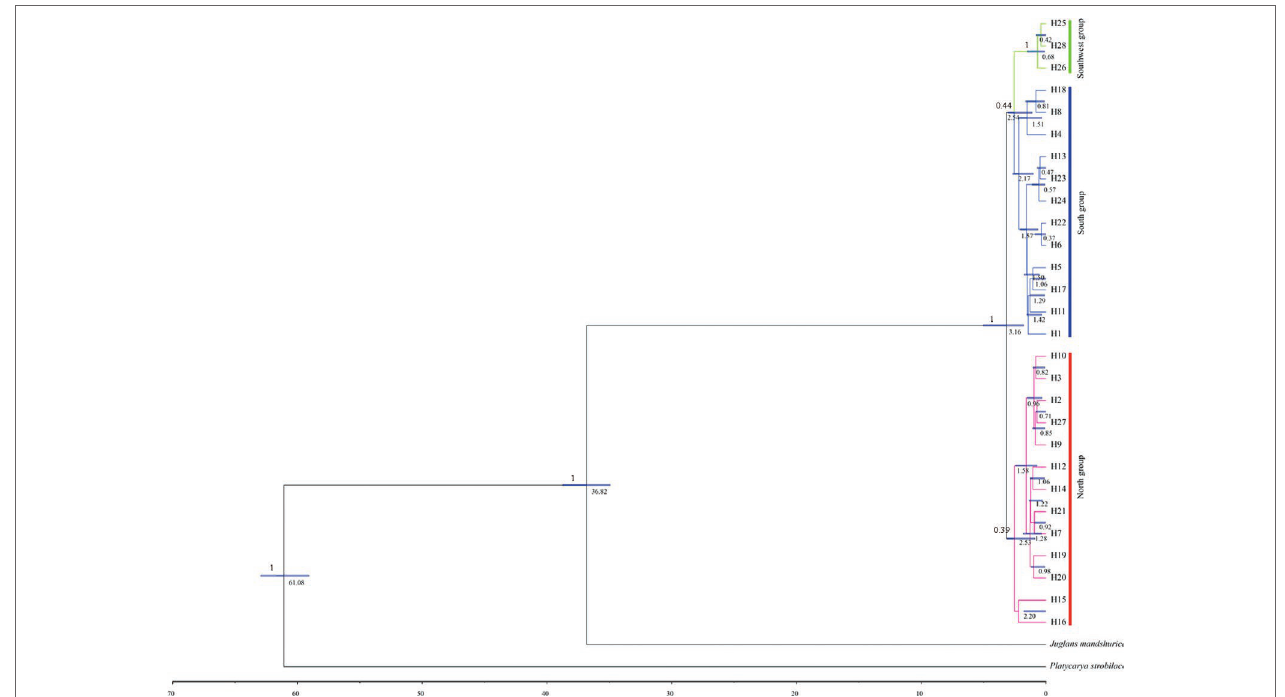
FIGURe 3 | Divergence time of Pterocarya stenoptera based on chloroplast DNA (cpDNA) haplotypes estimated with BEAST. Blue bars indicate the 95% credibility intervals of divergence times. The time of divergence of all nodes are showed below branches, and posterior probabilities are given above the main branches.